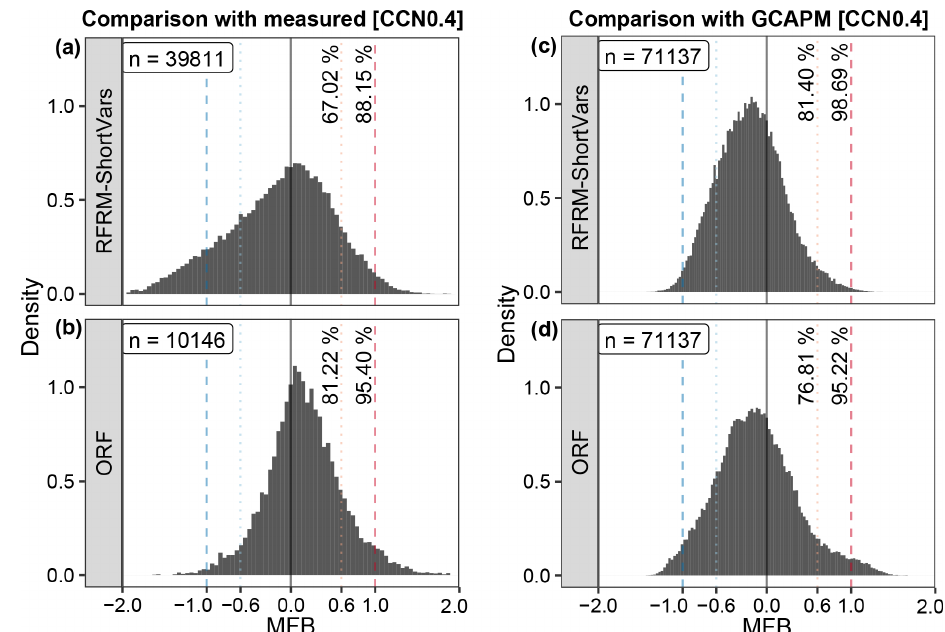
Figure 13. Mean fractional bias (MFB) of the random forest derived [CCN0.4] compared to expected values. (a, b) Comparison with measured [CCN0.4]. (c, d) Comparison with GCAPM simulated [CCN0.4]. The histograms show the pairwise counts (total is inset top-left in each panel) by MFB. The lines indicate MFB of 0 (black), + 1 (dashed red), − 1 (dashed blue), + 0 . 6 (dotted red), and − 0 . 6 (dotted blue). The percentage of RFRM derived values in good ( | MFB | < 0 . 6) and fair ( | MFB | < 1) agreement are shown close to the + 0 . 6 and + 1 . 0 MFB lines,